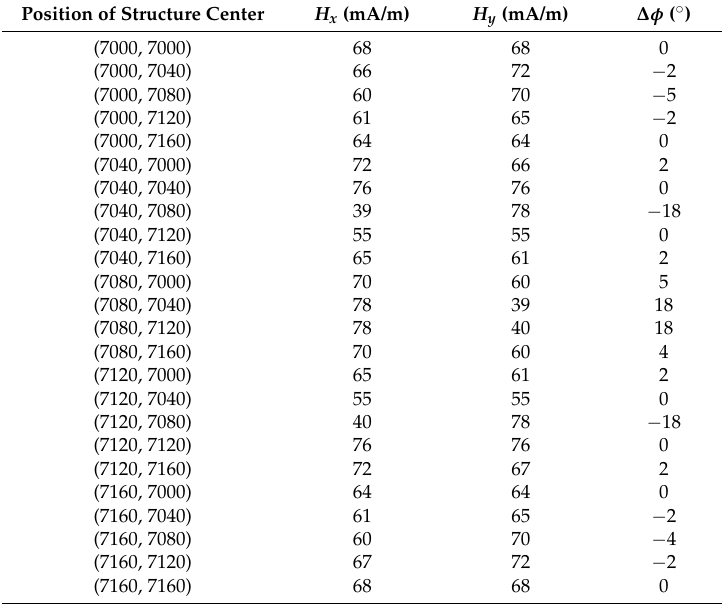
Table 3. FDTD-computed peak values of H x and H y , and azimuth errors estimated from Equation (2) for the case of true azimuth φ equal to 45 ˝ and current risetime equal to 3 µ